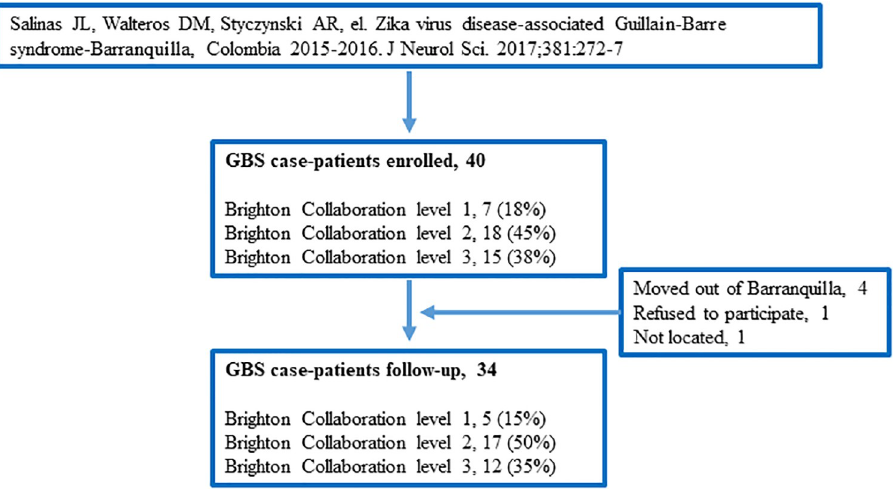
Fig 1. Flow diagram for selection of GBS patients � . � Adapted from Salinas JL, Walteros DM, Styczynski A, et al. Zika virus disease-associated Guillain-Barre syndrome-Barranquilla, Colombia 2015–2016. J Neurol Sci . 2017;381:272–277.